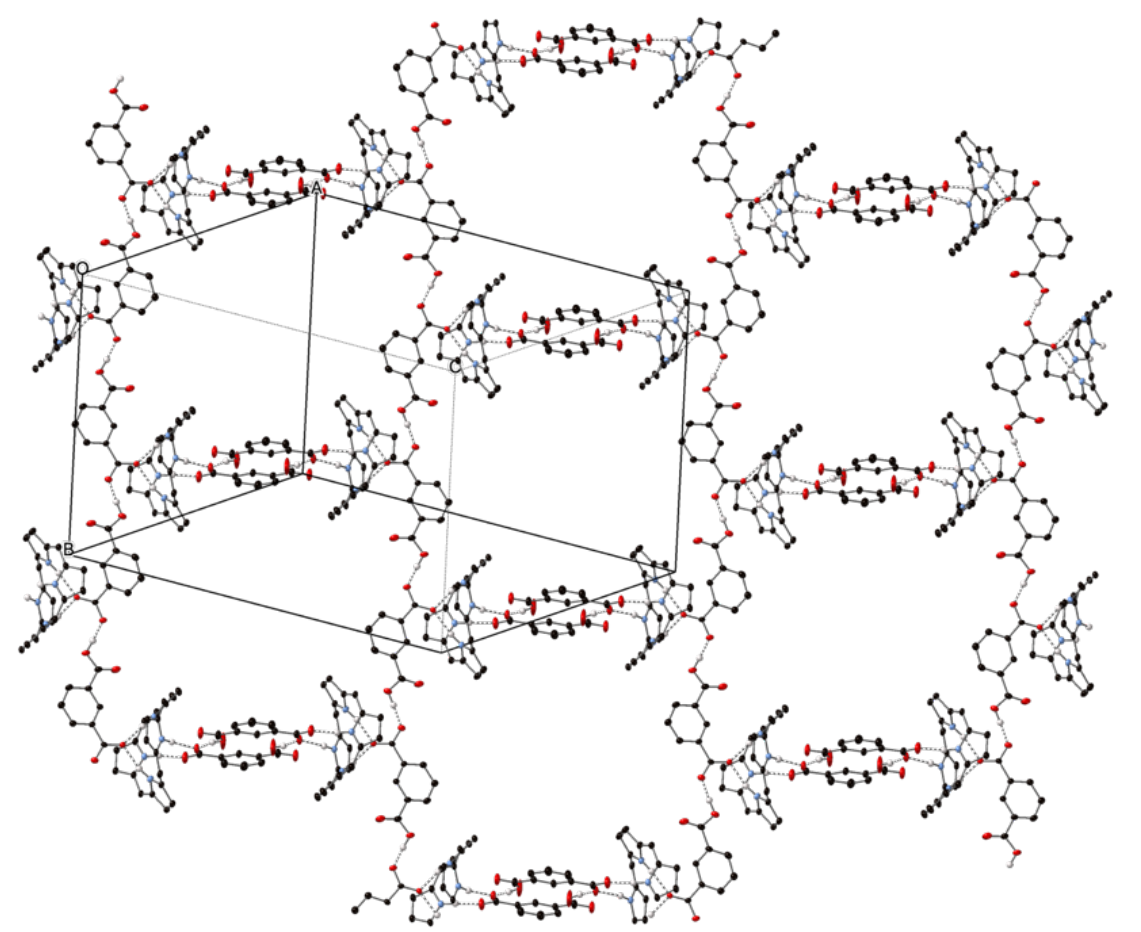
Figure 9. The irregular hexagonal net of the porphyrindiium bis(hydrogen phthalate) crystal of compound H 4 OiBuTPP(H(Pth)) 2 . Side chains on the porphyrin component, H atoms not involved in H-bonding, and solvates are omitted.